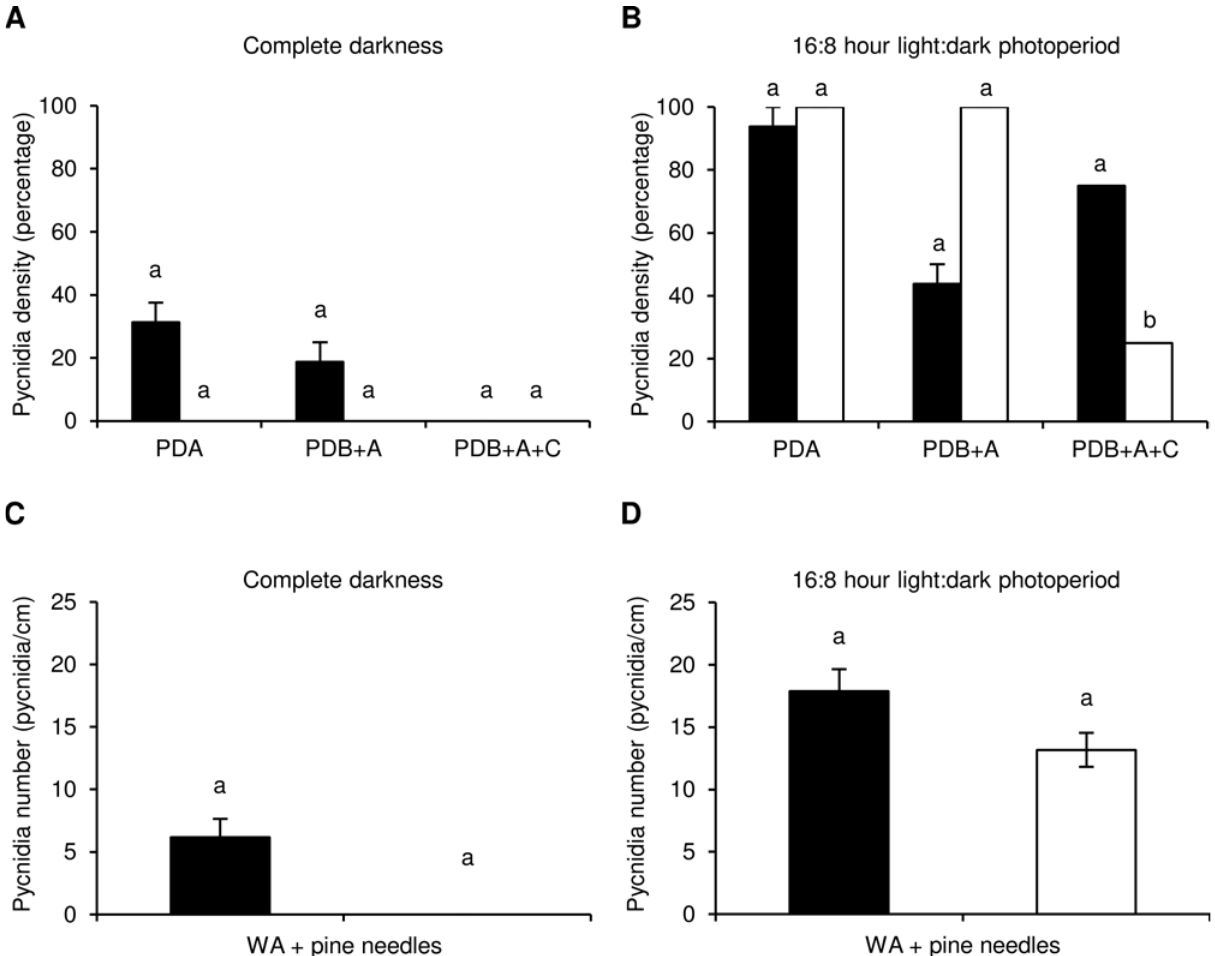
Figure 2. Pycnidium production from Diplodia seriata S (black) and D. seriata VT (white) grown on potato dextrose agar (PDA), potato dextrose broth supplemented with agar (PDB+A), PDB+A supplemented with cellulose (PDB+A+C) and water agar supplemented with pine needles (WA + pine needles). Pycnidium production was assessed, a, b) as the percentage of Petri plate surface covered by D. seriata pycnidia, or c, d) as the numbers of pycnidia per centimetre of pine needles 28 d after growth in complete darkness or with a 16:8 hour light:dark photoperiod at 27°C. The Kruskal-Wallis test showed no significant differences between two experimental repetitions ( P > 0.05, n = four replicates per experiment) and data from the two experiments were pooled. Means and standard errors of eight replicates (dishes) from the two experiments are shown for each fungal strain and growth medium. Different letters indicate significant differences (Kruskal- Wallis test; P ≤